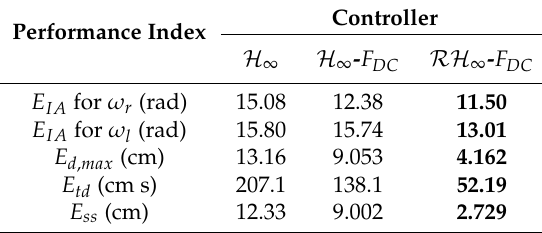
Table 4. Numerical performance evaluations. Each result is an average of three trials. The least value for each row is written in bold.